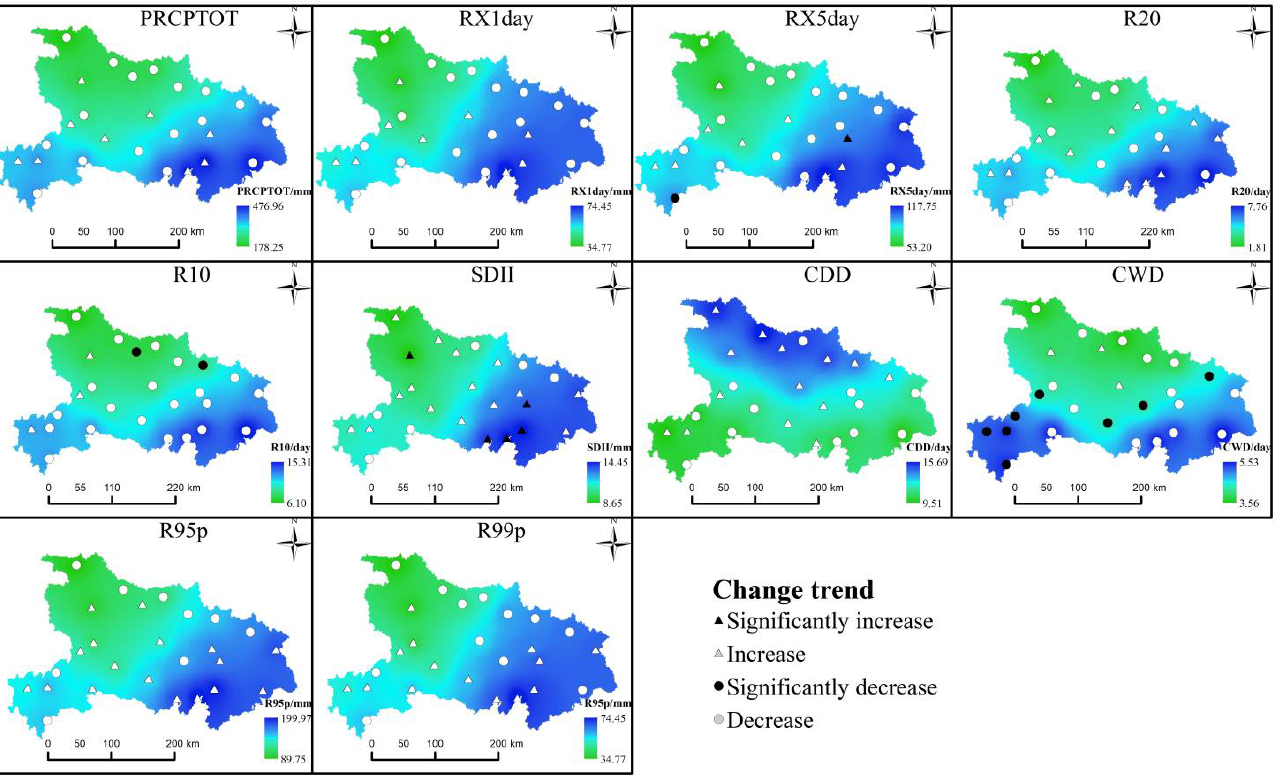
Figure 9. Spatial variations of spring average EPIs and the changing trend of spring EPIs for each station within Hubei province. station within Hubei